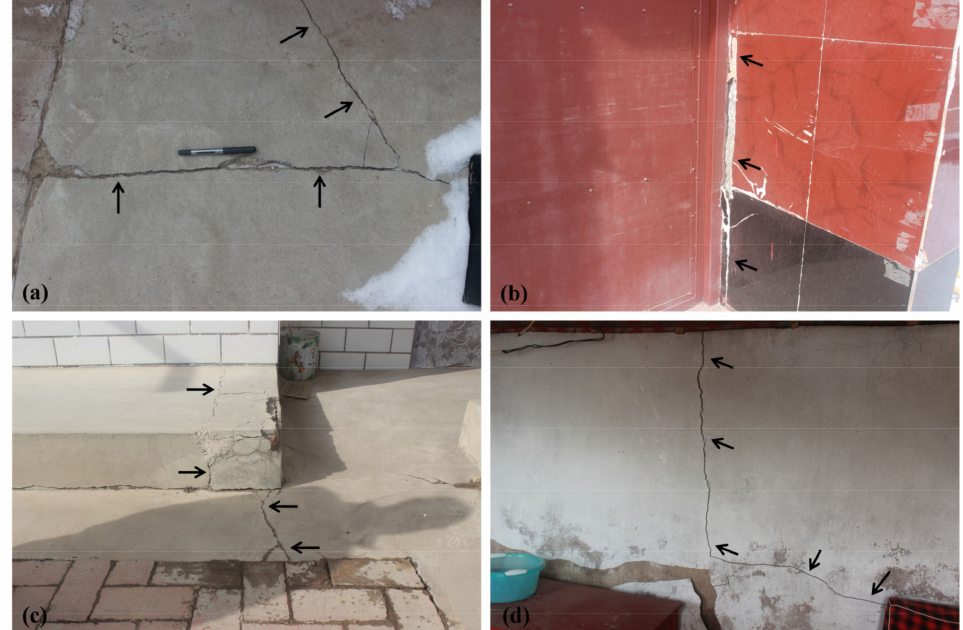
Figure 14. Field work photos showing some damage to roads and buildings caused by the tunnel excavation, where the black arrows indicate the cracks. ( a ) The damage to the road; ( b ) the damage to the building; ( c ) the damage to the road; and ( d ) the damage to the building. Two representative points (i.e., Points P1 and P2 marked in Figure 13) were selected to characterize the temporal evolution behavior of the surface displacement related to the tunnel excavation. Figure 15 shows the time series of the displacement at Points P1 and P2 derived from ascending and descending Sentinel-1 images, spanning the period from December 2015 to March 2021. We can see that the displacement time series calculated with the ascending and descending Sentinel-1 images show a good consistency at each selected point, illustrating the reliability of the estimated displacement results. Evidently, non-linear displacement features were observed at Points P1 and P2. Ground surface was in a stable state before 13 April 2016 for Point P1 and before 2 November 2016 for Point P2, followed by a sudden acceleration displacement signal; this indicated that the tunnel excavations at Points P1 and P2 might have started on 13 April 2016 and 2 November 2016, respectively. The surface displacement developed progressively in accordance with tunnel excavation and advanced, and a progressive deceleration in displacement started to occur after the tunnelling completion on 18 September 2018. However, the entire area above the tunnels has not yet been completely stabilized by March